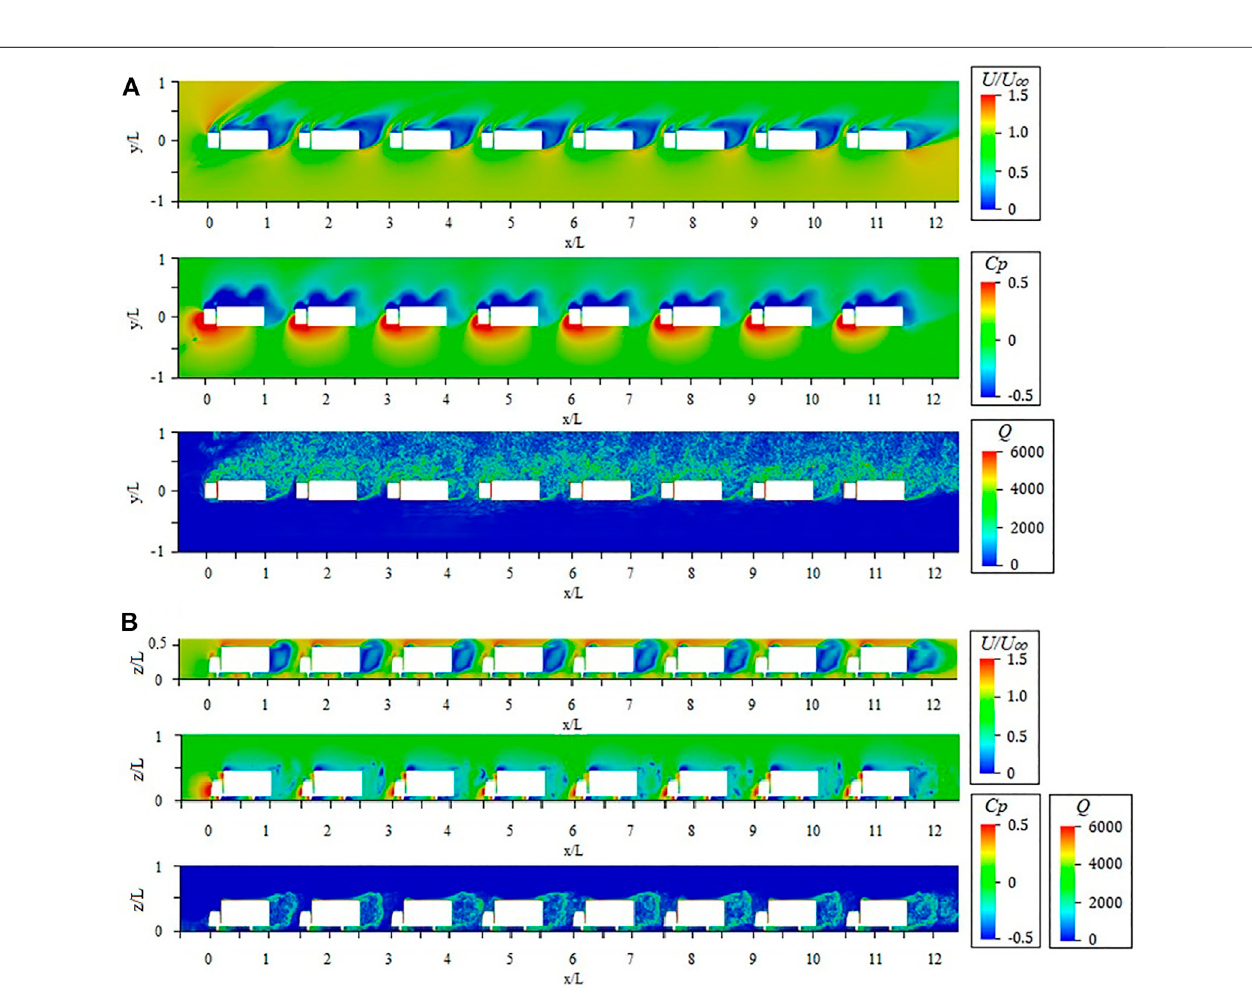
Frontiers in Future Transportation |